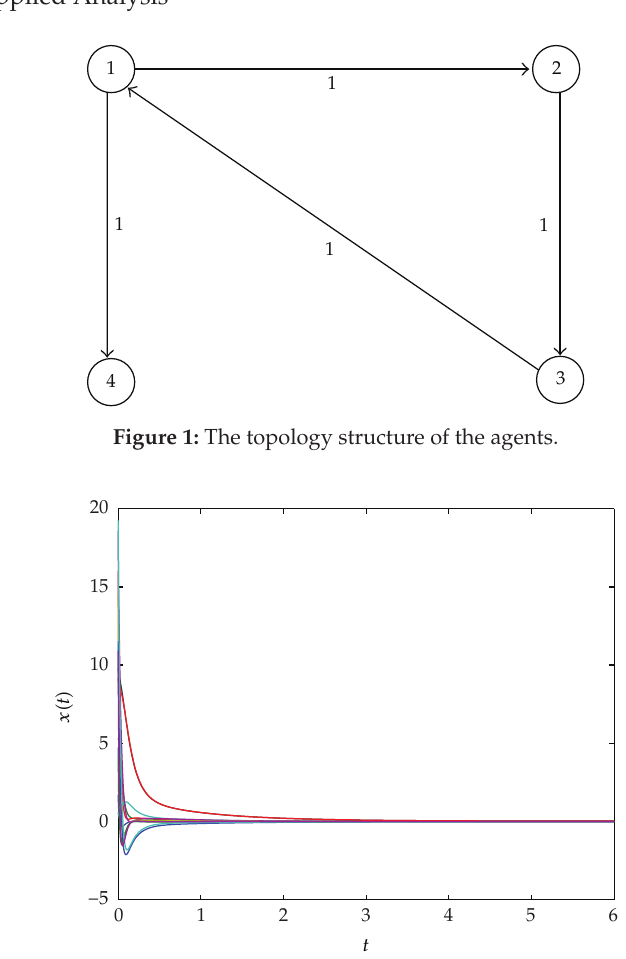
Figure 2: The position curves x i (cid:6) t (cid:7) (cid:6) i (cid:8) 1 , 2 , 3 , 4 (cid:7) for fractional-order α (cid:8) 0 .